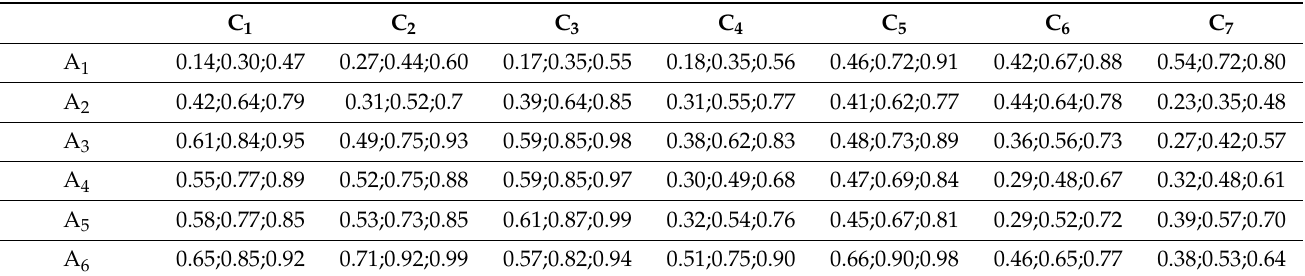
Table 9. Weighted normalized decision matrix.